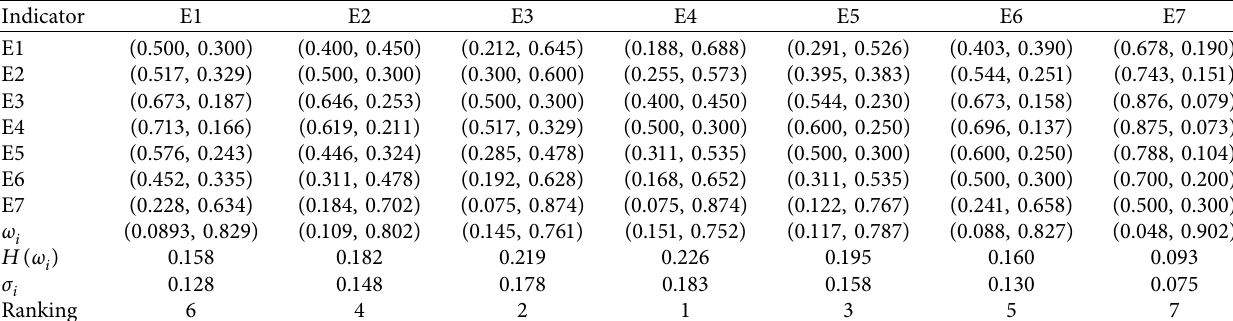
Table 7: The importance levels of the corrected evaluation indicators and weighting results.